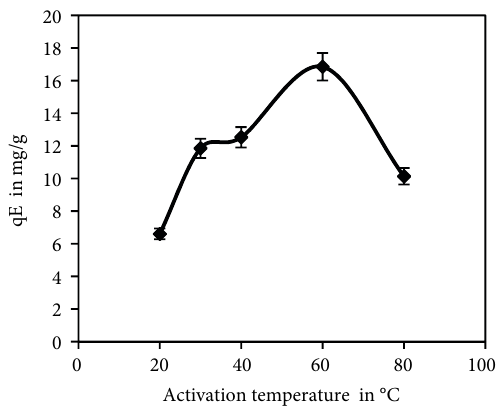
Fig. 3. Effect of activation temperature at 20% by weight acid con centration, impregnation ratio 1:8 and speed of